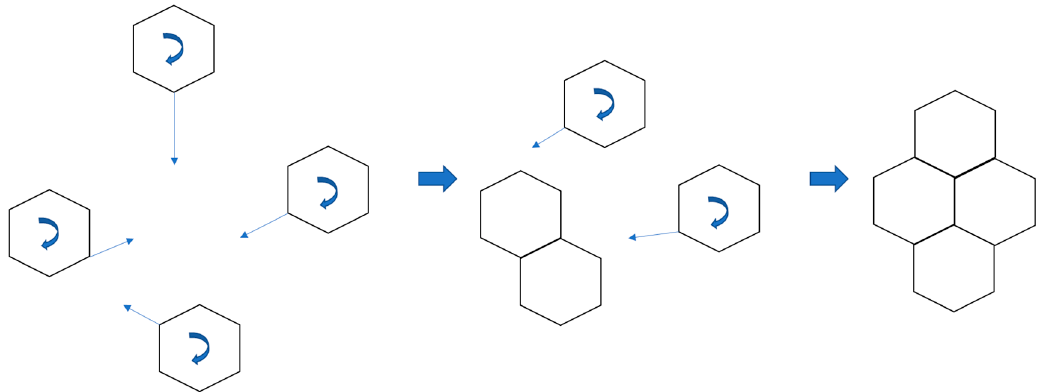
Figure 1. Schematic representation of a mechanism of the self-organizing formation of a graphene layer.